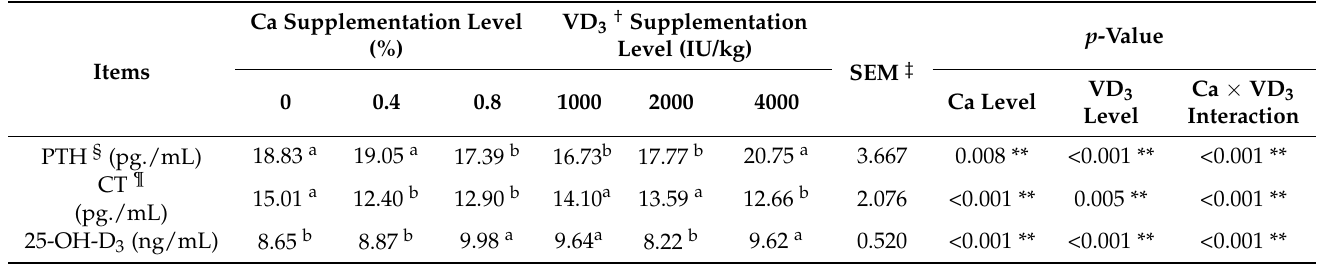
Table 7. Effects of dietary Ca and VD 3 supplemental levels on serum hormone in growing blue foxes (LS means ±